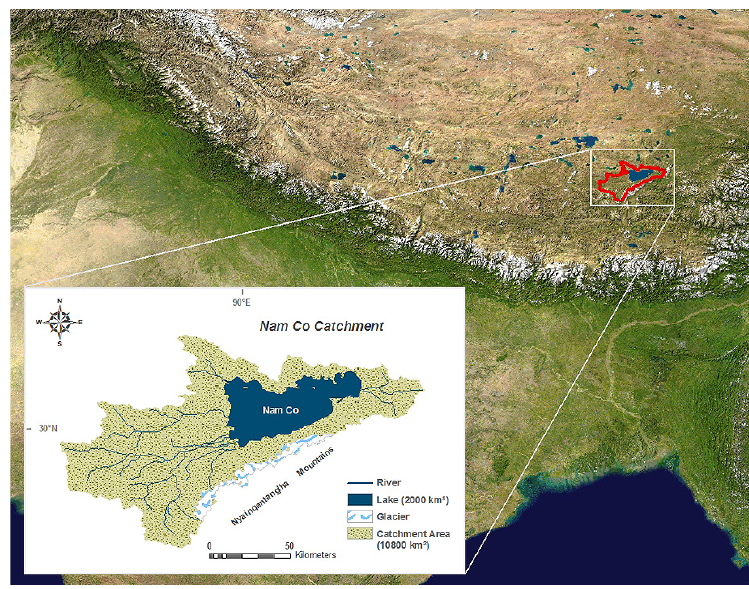
Fig. 1. Nam Co basin test site and its position on the Tibetan